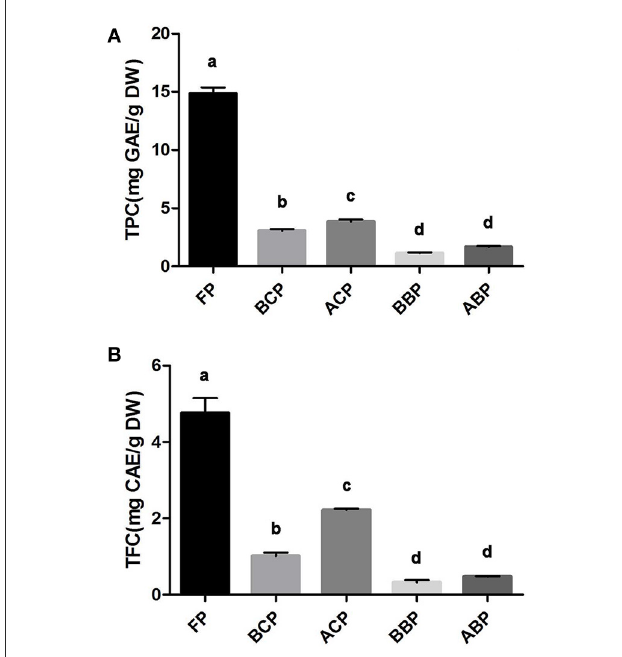
FIGURE1 TPC (A) and TFC (B) in different fractions of hazel leaf, data are presented as means ± SD ( n = 3), values not sharing a common superscript letter denote significant difference ( p <